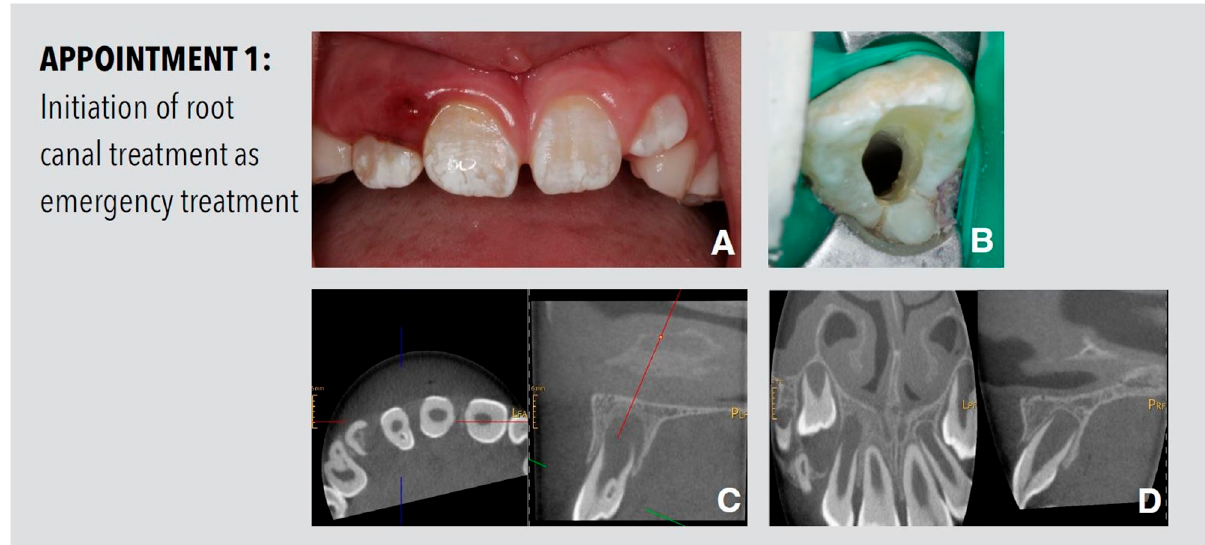
Figure 1. Procedures performed at the first appointment. ( A ) Preoperative clinical view of the maxillary front teeth showing swelling and redness of the gingiva in proximity to the right lateral incisor. ( B ) Initial access cavity. ( C ) Preoperative diagnostic CBCT shows the palatal invagination with partial enamel lining on tooth 12. ( D ) The sagittal view of the CBCT shows the periapical radiolucency associated with tooth 12 and arrested root development of tooth 12 in comparison to the unaffected tooth 22. The transversal projection of tooth 22 is shown on the right-hand